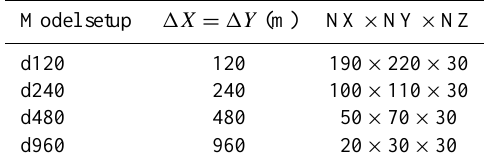
Table 1. Model setup indicating the horizontal grid resolution ( (cid:49) X = (cid:49) Y) and domain discretization.